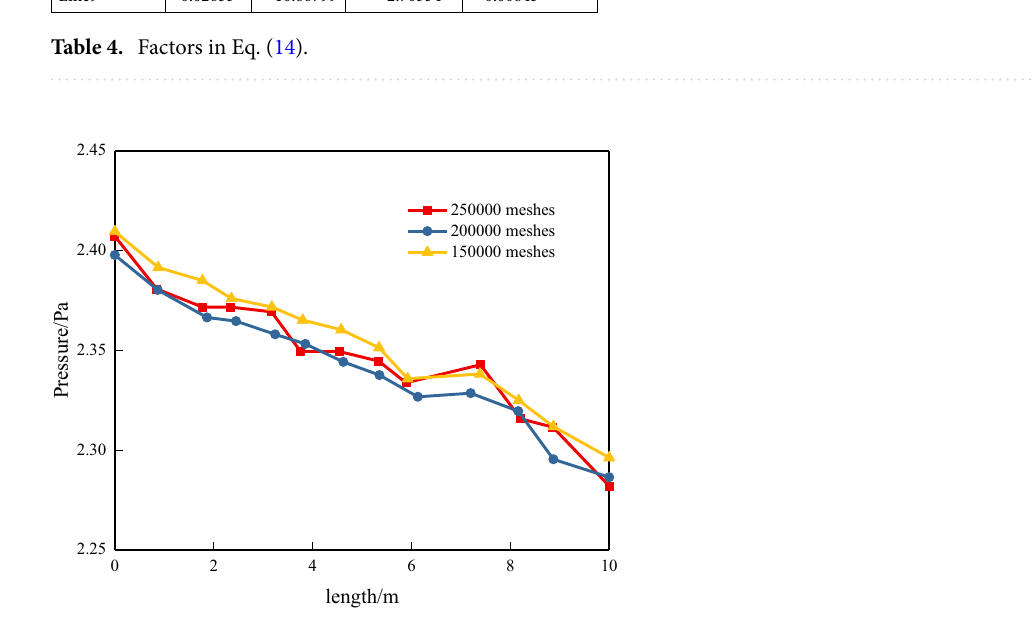
Figure 7. Grid independence